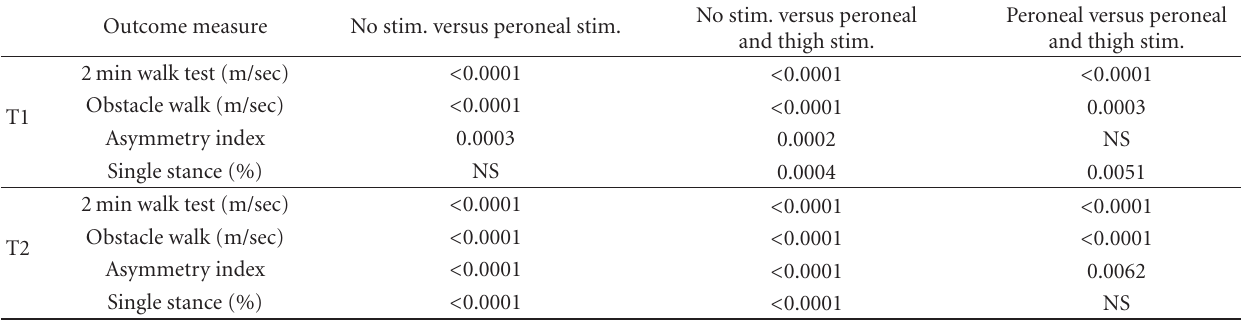
Table 2: Post hoc analysis comparing all pairs of conditions (at T1 and T2). P values are presented only when the results were significant ( P value < Holm’s critical